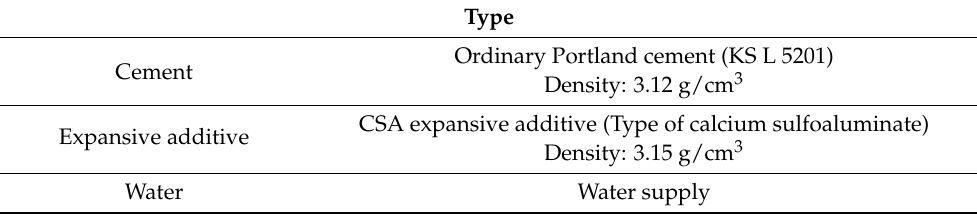
Table 2. Materials used.